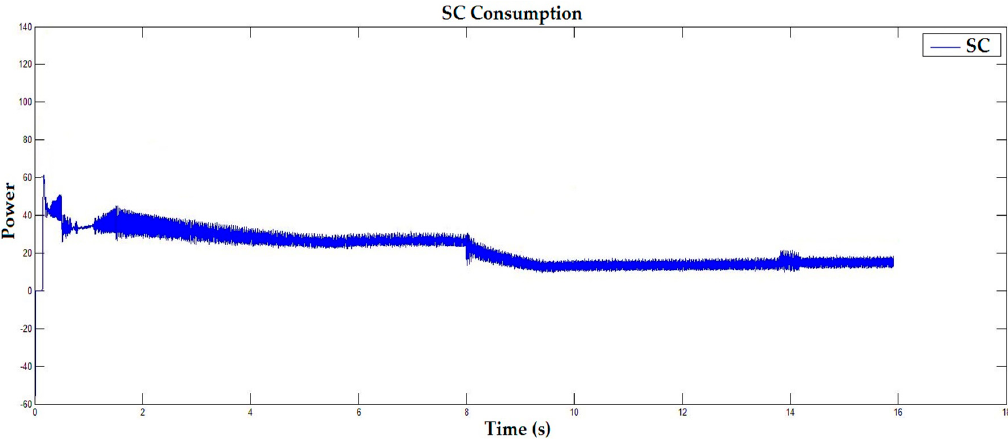
Figure 16 . Supercapacitor power consumption.